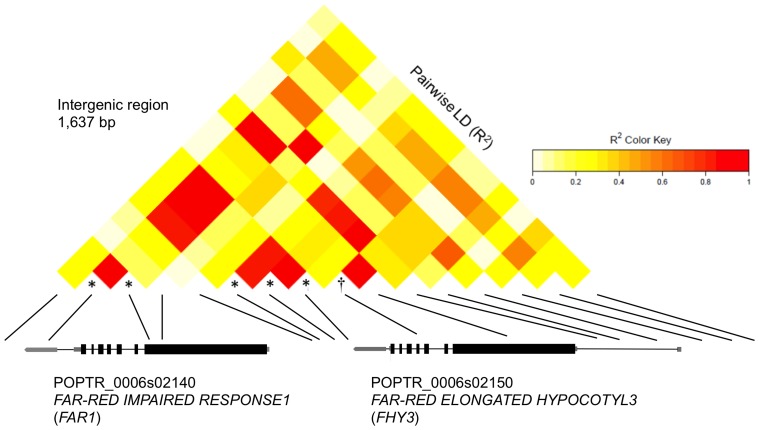
Pairwise linkage disequilibrium plot of FAR-RED IMPAIRED RESPONSE1 and FAR-RED ELONGATED HYPOCOTYL3 with gene structures.SNPs significant in 2010 are indicated with an asterisk; SNPs significant in 2011 are indicated with a cross. Scaffold_6_ 1402770 in the intergenic region had the highest significance (P = 3.64×10−6) and explained 2.5% (R2 = 0.025) of the phenotypic variance in 2010.